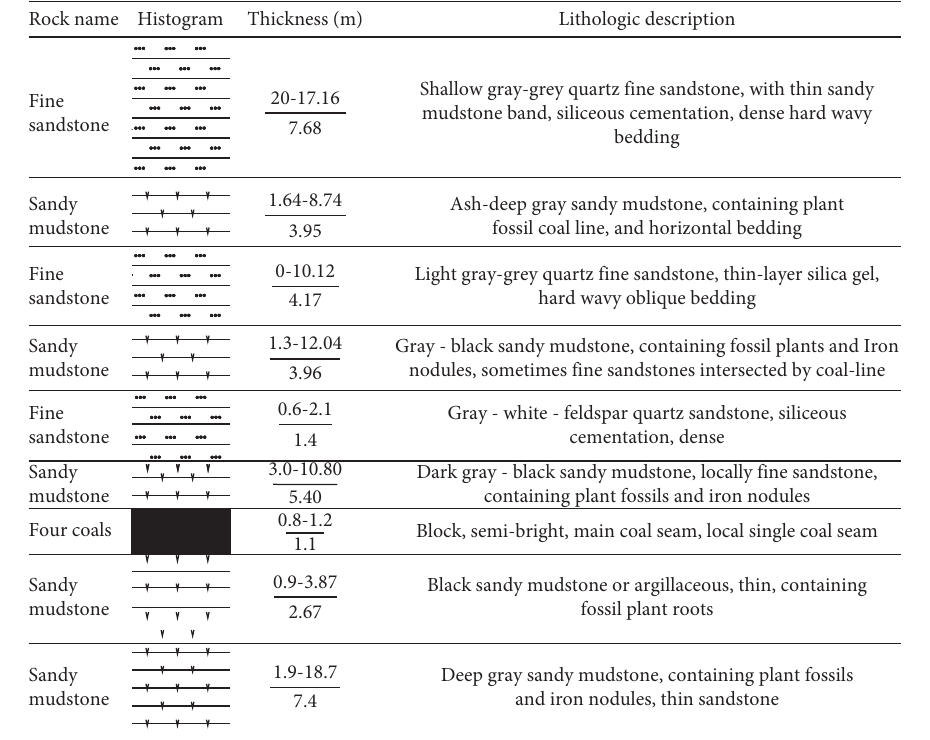
Figure 1: Comprehensive histogram of mining area 5249.